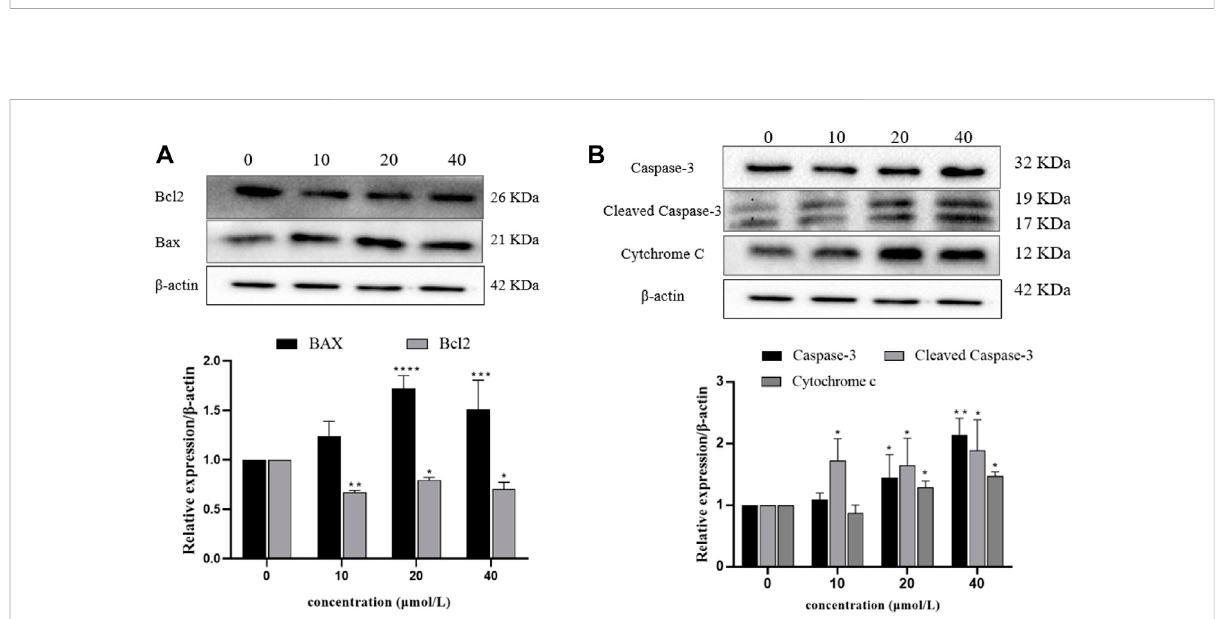
Expression levels of apoptosis-related proteins in 786-O cells after RFA treatment. Western blotting was used to determine. (A) The expression levels of Bax and Bcl-2 proteins. (B) The expression levels of Caspase-3, Cleaved Caspase-3, and Cytochrome c proteins. Data were expressed as mean ± SD. t -test was used for the statistical analysis. * p < 0.05, ** p < 0.01, *** p < 0.001, **** p < 0.0001, versus the untreated control